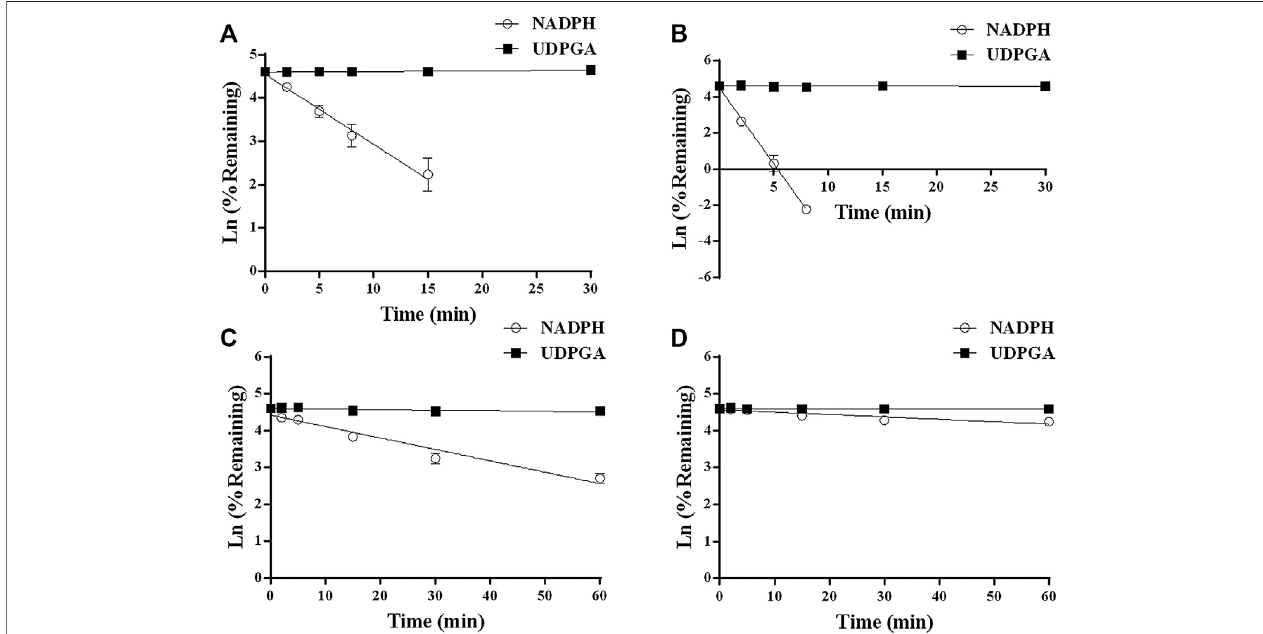
FIGURE 2 | Comparison of P450 and UGT depletion pro fi les of YL-IPA08 in HLM (A) , RLM (B) , HIM (C) , and RIM (D) . Open circle represents P450 metabolism, closed square represents glucuronidation (n (cid:2)